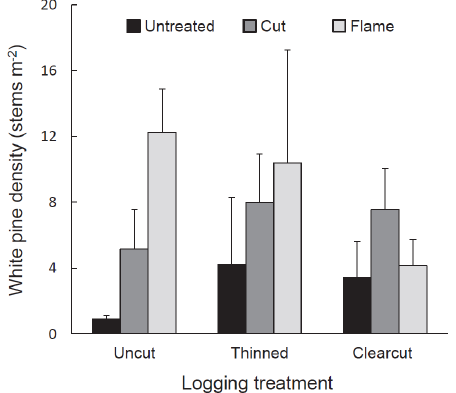
Figure 3. Density (individuals m − 2 ) of eastern white pine seedlings in relation to logging treatment (uncut control, thinned, clearcut) and buckthorn treatment (untreated, cut, flame) at MacDonald Lot, Durham, NH, USA in 2012, the third year after logging. n = 27 subplots.